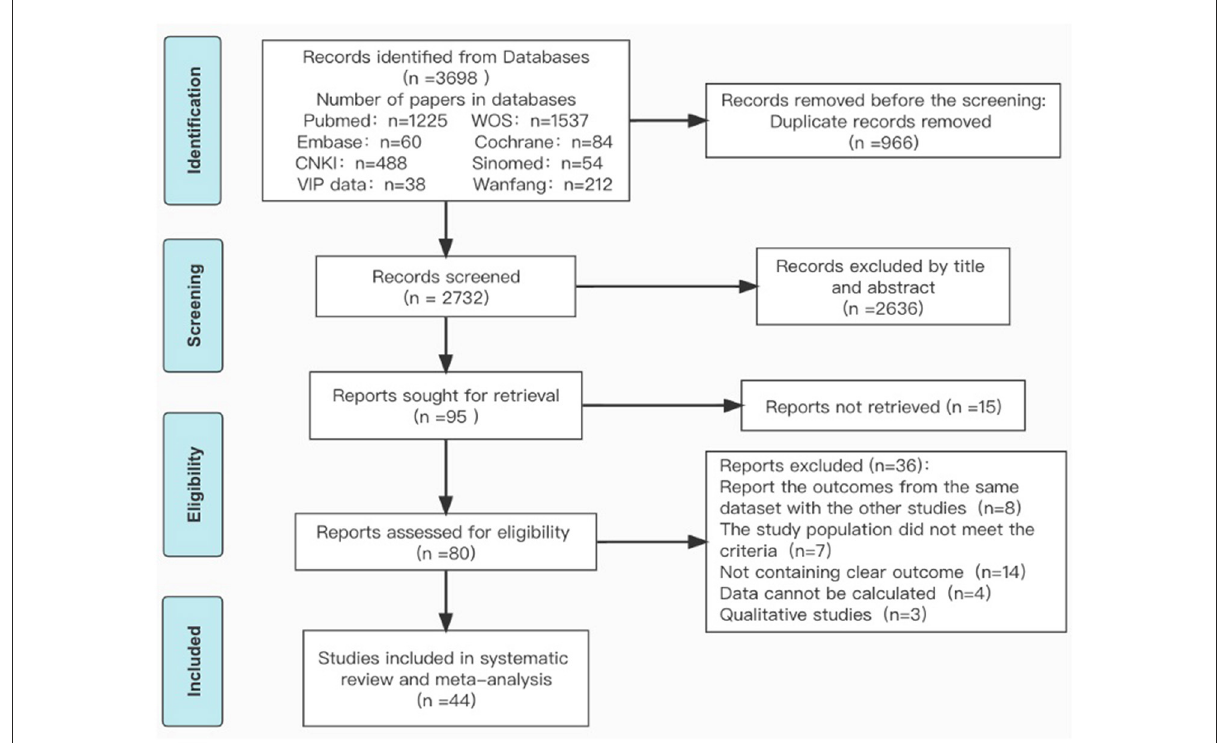
FIGURE1 Flow chart of literature search and selection procedures and